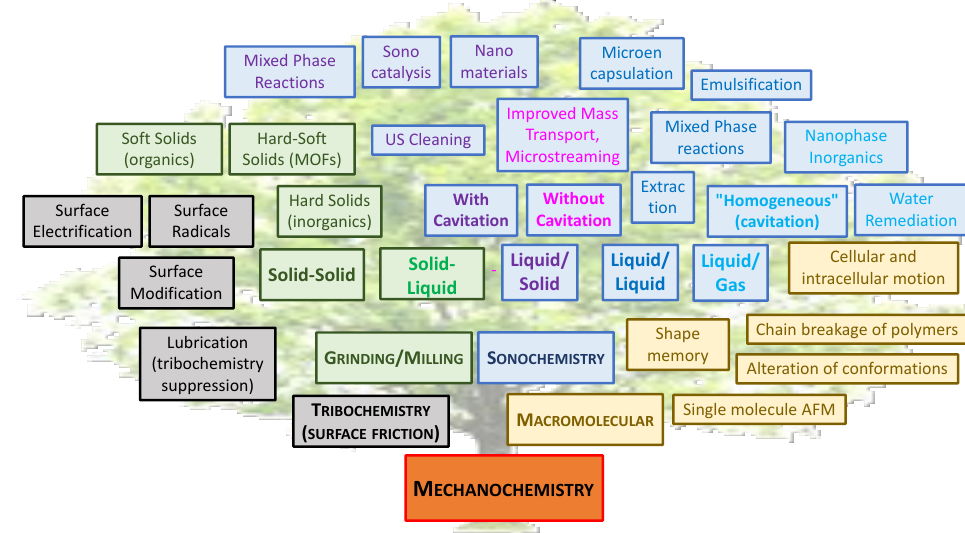
Figure 1. Tree of mechanochemical transformations, inspired by Suslick. [8] (AFM: Atomic Force Microscopy; MOF: Metal-Organic Framework).